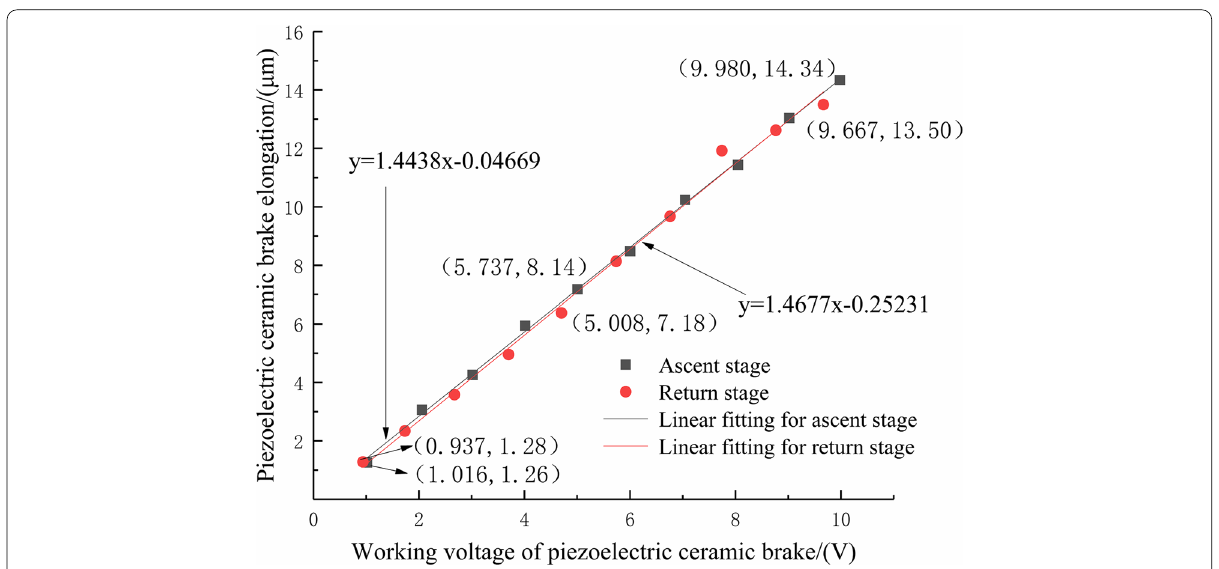
Fig. 5 Linear fitting diagram of driving performance of